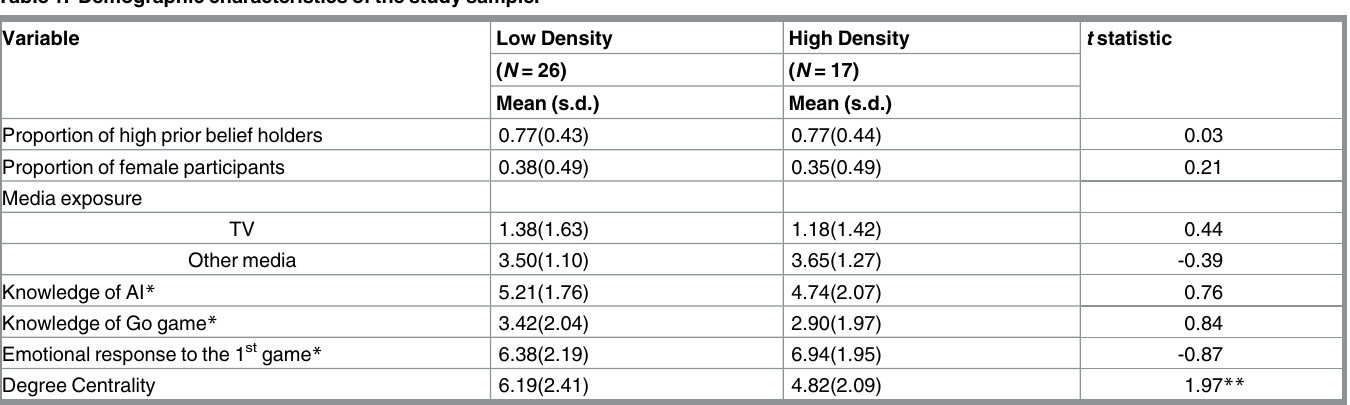
Table 1. Demographic characteristics of the study